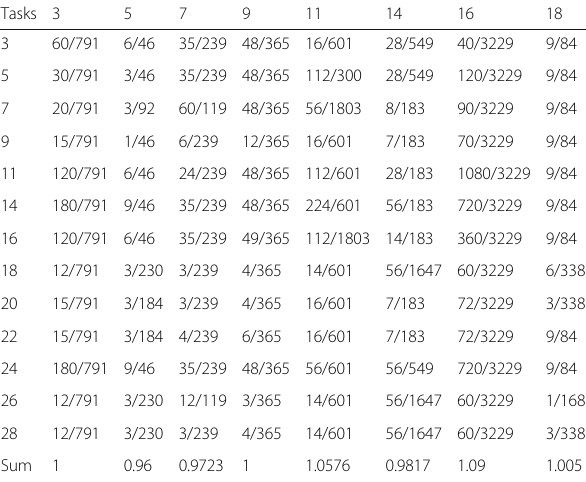
Table 3 Summation of each column-I Task